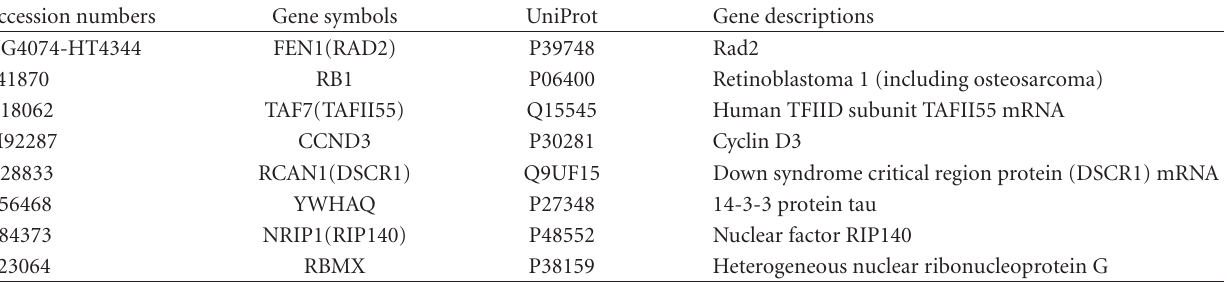
Table 5: Di ff erentially coexpressed genes correlated in ALL but not in AML in Leukemia